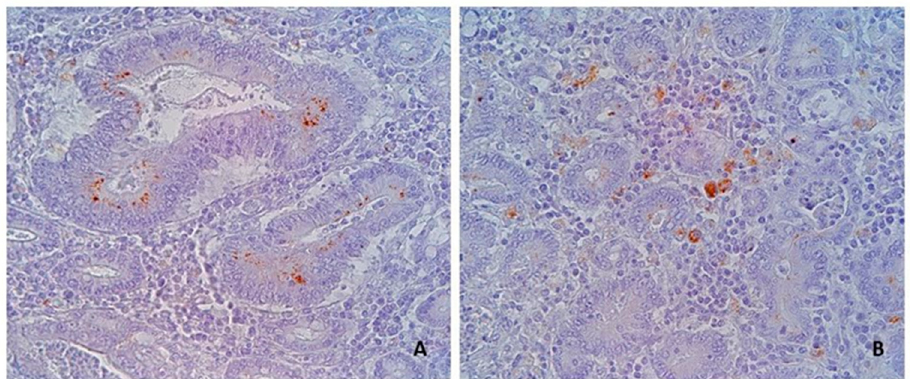
Figure 2. Swine ileum, Case ID 1: Immunohistochemistry to L. intracellularis showing a positive stain in the apical cytoplasm of the cells in the crypts ( A ) and in macrophages ( B ) in the mucosal interstitium. ( A , B ): 40 ×